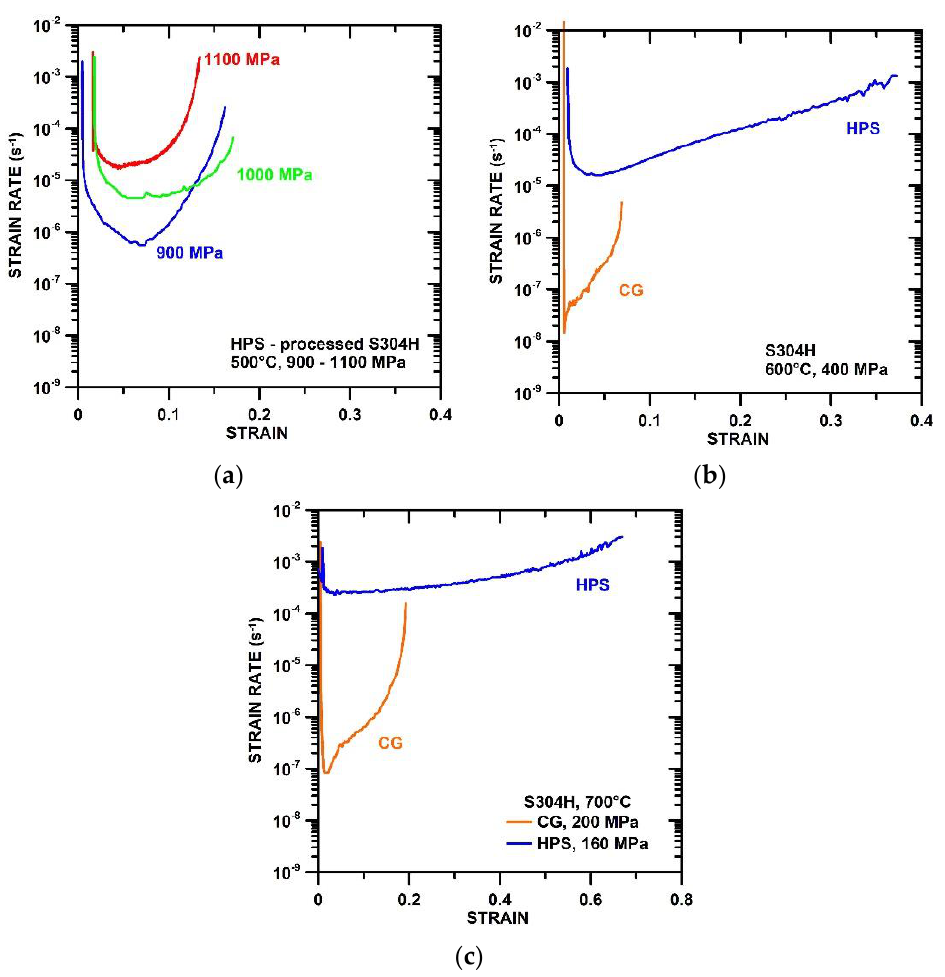
Figure 4. Strain rate vs. strain dependences measured at ( a ) 500 °C for HPS-processed state, ( b ) 600 °C for CG and HPS-processed states and ( c ) 700 °C for CG and HPS-processed state. The CG S304H steel exhibits short primary stadium and 𝜀̇ 𝑚𝑖𝑛 occurred up to strain about 0.02. The largest part of creep strain in HPS and also CG state tested at 600 °C and 700 °C occurs during the tertiary stage.